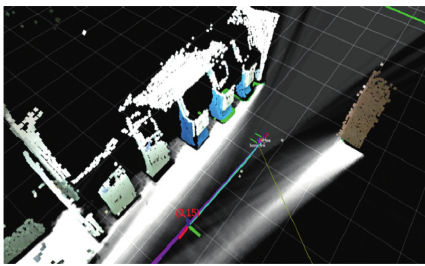
Figure 5: Binding of point cloud data to the